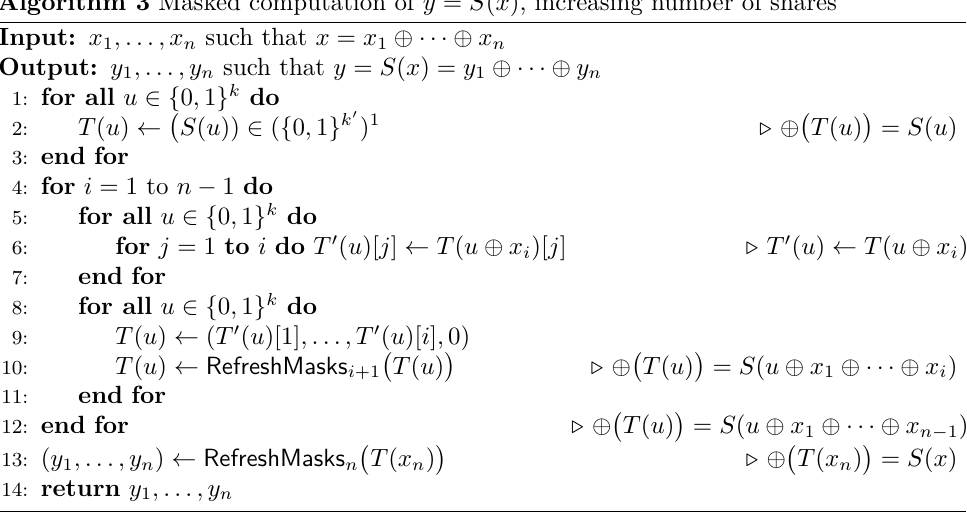
Algorithm 3 Masked computation of y = S ( x ), increasing number of